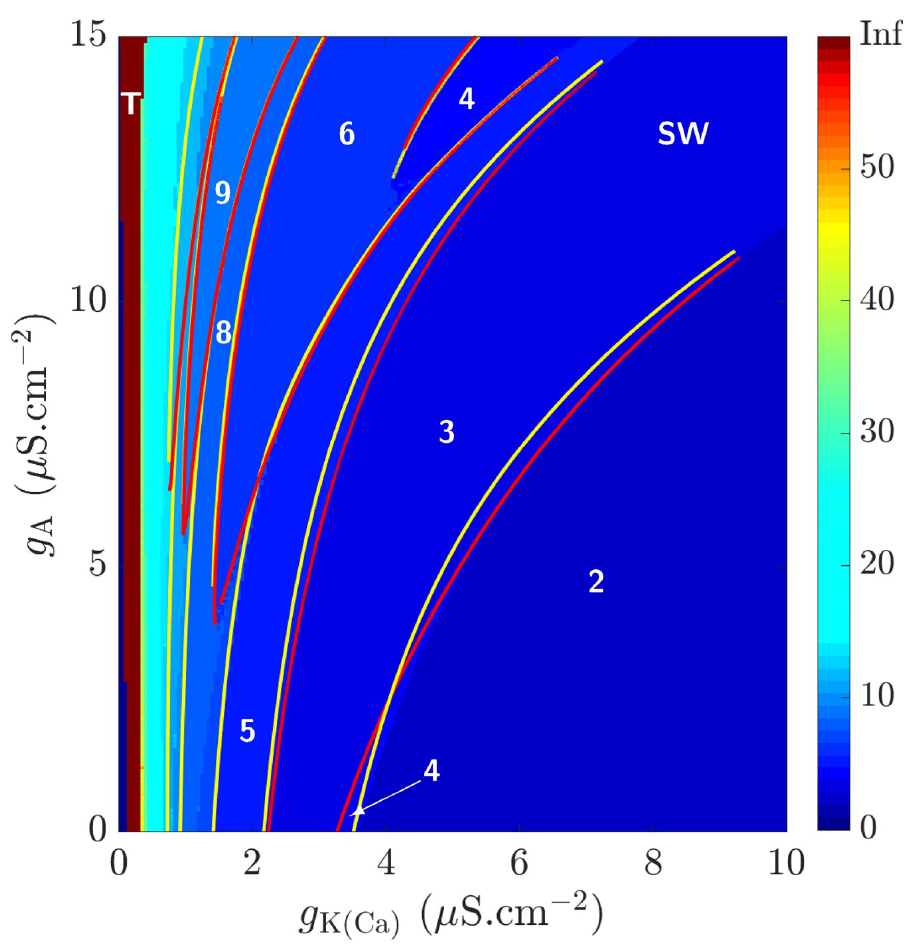
Fig 9. Color-map of the various regimes of behavior associated with the full system (1) in the ( g K(Ca) , g A )-plane, when g HVA = 0.249 μ S.cm − 2 . The square-wave bursting regime, labeled SW , is color-coded based on the number of spikes in its corresponding BPOs, calibrated according to the color-bar to the right. For further clarity, the number of spikes in various regions of SW are displayed. The number of spikes increases as g K(Ca) decreases such that for small values of g K(Ca) , the system transitions to tonic firing (labeled T ). The yellow and red curves are two-parameter continuation of the period-doubling and saddle-node bifurcations of periodic orbits detected in Fig 8 A , respectively.